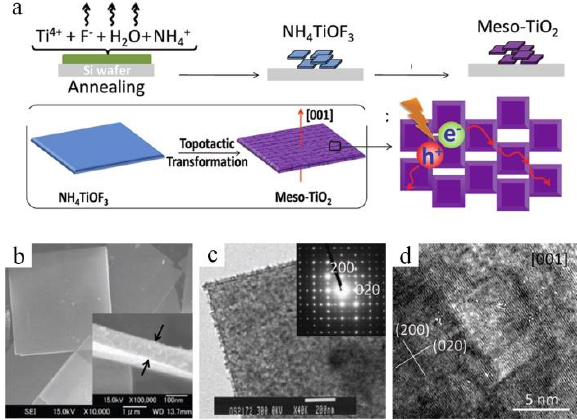
Figure 3. ( a ) Schematic presentation of oriented topotactic formation of anatase TiO 2 mesocrystals with dominant (001) facets; ( b ) SEM; ( c ) TEM; and ( d ) HRTEM images of anatase mesocrystals. The inset displays the related SAED pattern. Reprinted with permission from [135]. Copyright American Chemical Society, 2012.